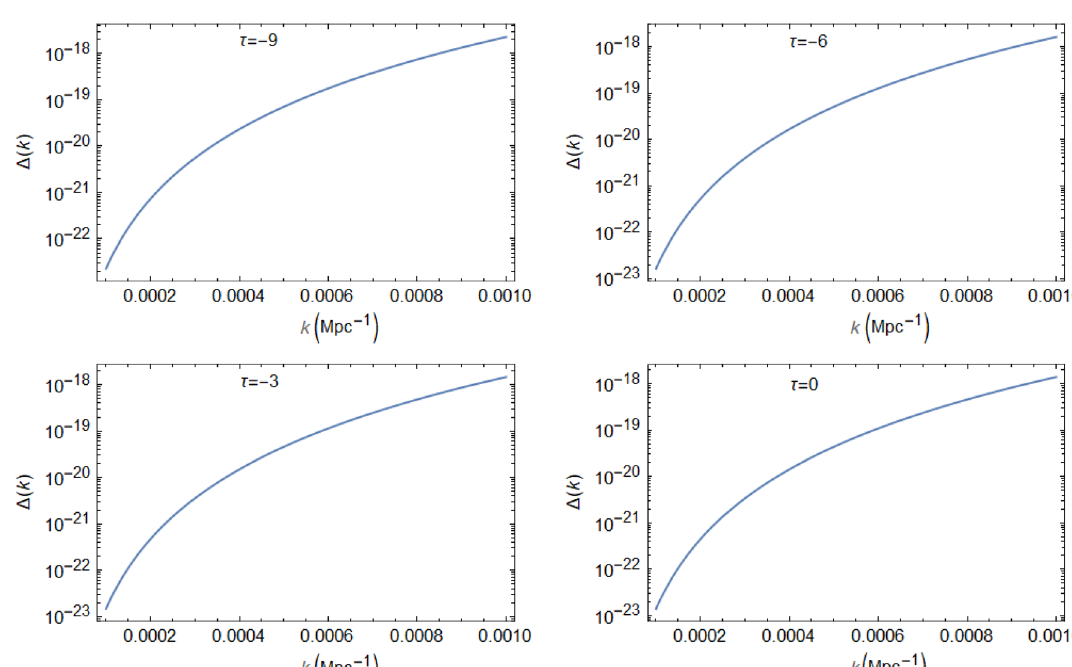
Fig. 2 (cid:16)( k ) vs k for four different values τ on log scale via perturbative